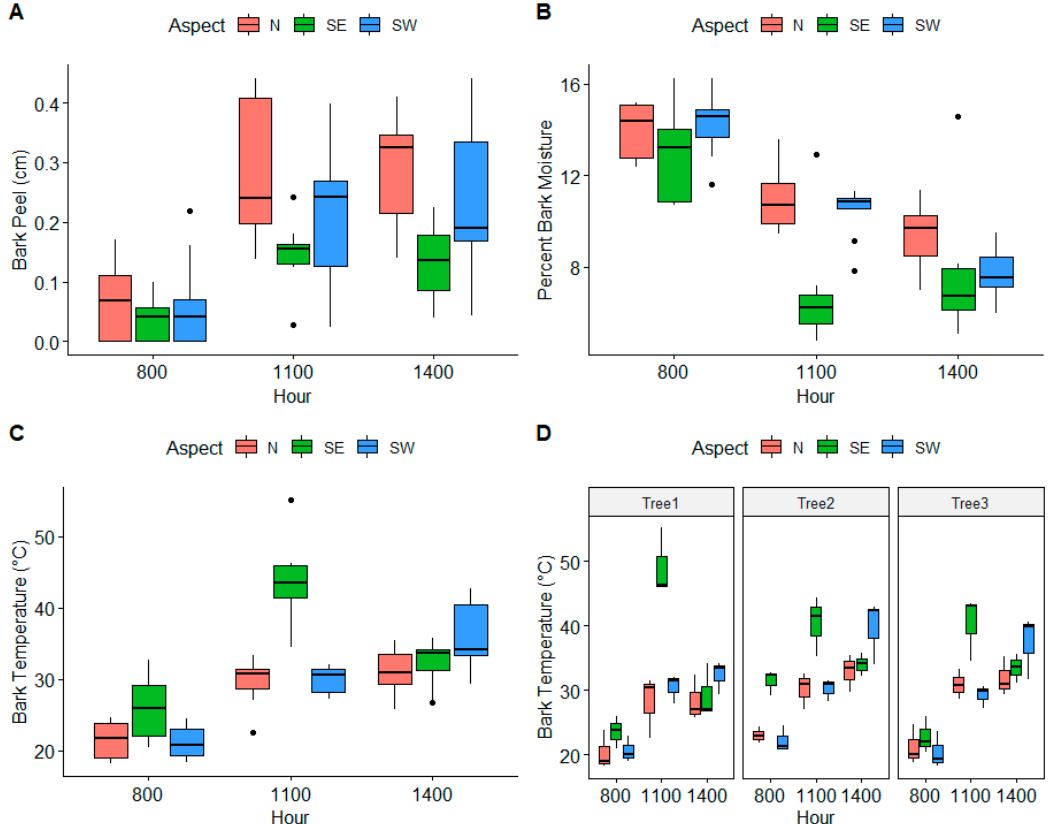
Figure 2. For longleaf pine ( A ) mean bark flake peeling distances (cm) over the duration of the experiment, by hour, separated by aspect ( n = 27). Peel distances were adjusted to the lowest point during the experiment. ( B ) Mean percent bark flake moisture over the duration of the experiment by hour, separated by aspect. ( C ) Mean bark surface temperatures ( ◦ C) over the duration of the experiment by hour, separated by aspect. ( D ) Three-way interaction of bark surface temperature ( ◦ C) by hour with aspect and tree location.